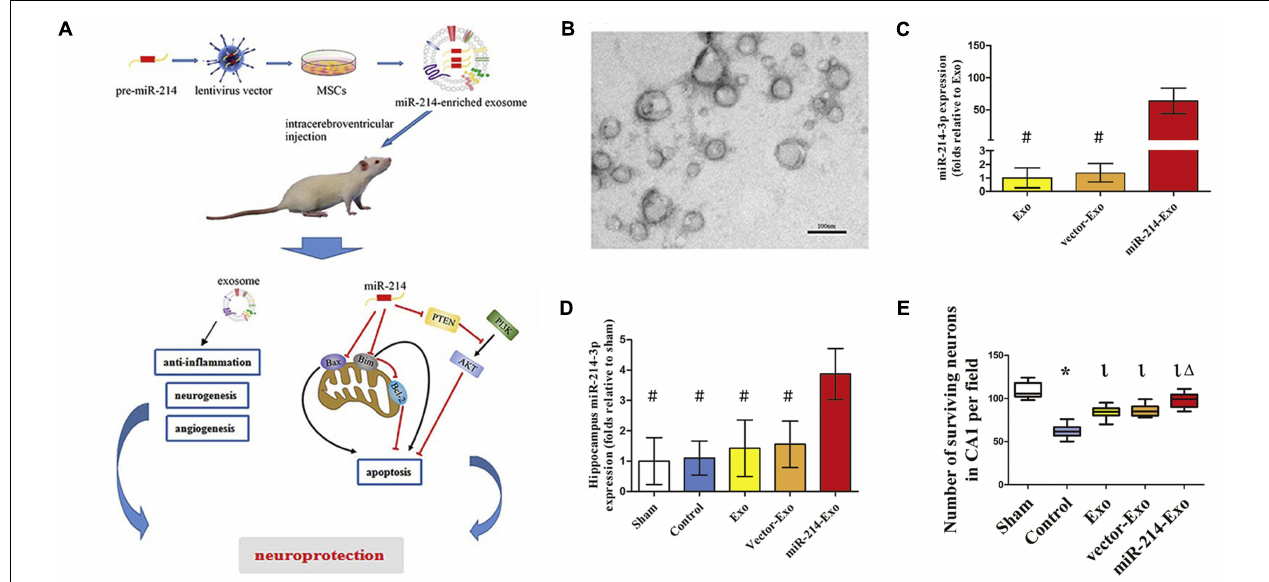
FIGURE 6 | Gene-modified exosomes protect the brain against prolonged deep hypothermic circulatory arrest. (A) Schematic illustration of the principle. (B) Electron microscopic image of miR-214–enriched exosomes. (C) miR-214-3p expression was enhanced significantly in cultured MSCs transfected with premiR-214 ( # p < 0 . 001 vs miR-214-Exo). (D) Intracerebroventricular injection of miR-214–enriched exosomes markedly enhanced the expression of miR-214-3p in the hippocampus ( # p < 0 . 001 vs miR-214-Exo). (E) Number of surviving neurons in CA1 area of hippocampus post administration (* p < 0 . 001 vs sham group, l p < 0 . 001 vs control group and (cid:49) p < 0 . 005 vs Exo group or vector-Exo group). Figure reprinted from Shi et al. (2021).